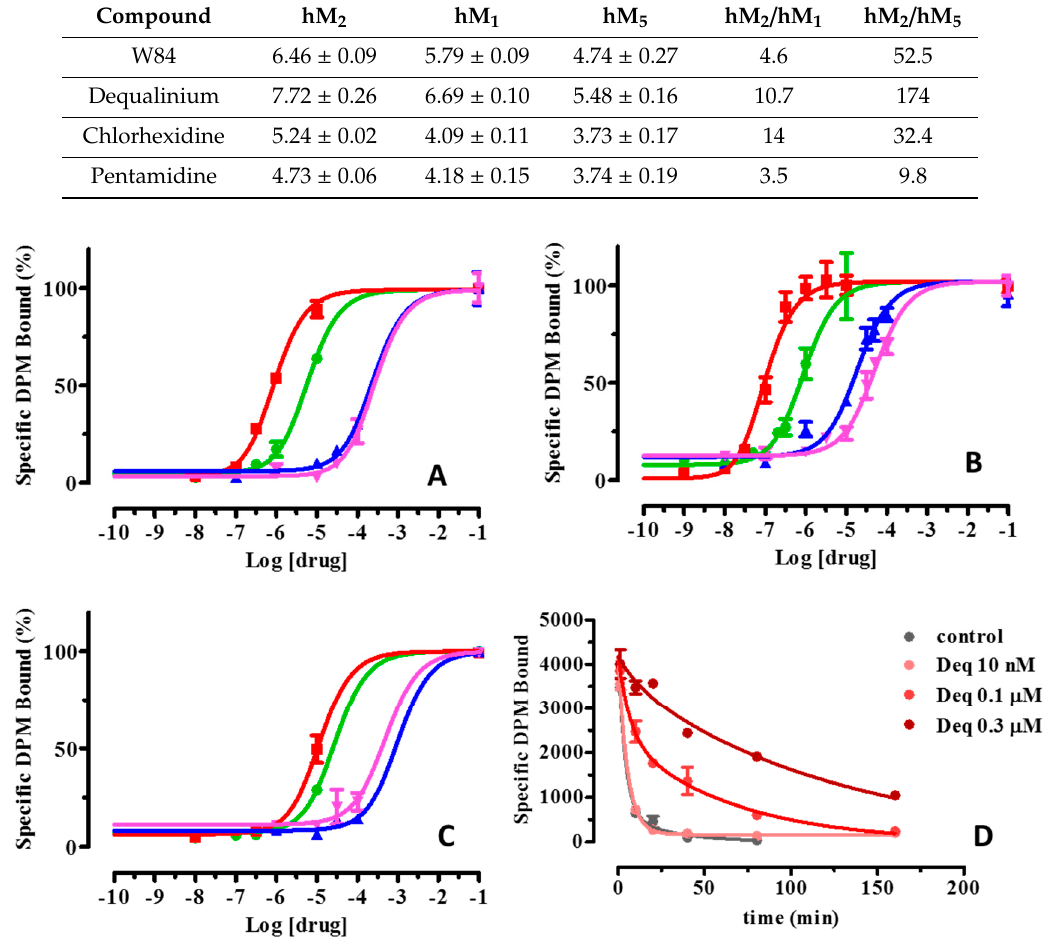
Figure 3. Effects on the [ 3 H]-NMS dissociation rate of three most interesting retrieved compounds (dequalinium: red squares, chlorhexidine: blue tringles and pentamidine: pink tringles) plus the reference W84 compound (green circles) as derived by single time-off rate experiments on ( A ) hM 1 , ( B ) hM 2 and ( C ) hM 5 . The data point at log [drug] = − 1 represents the [ 3 H]-NMS bound in the absence of added atropine and allosteric ligand; ( D ) shows a representative graph of the reduction of the dissociation rate (K off ) and the corresponding t 1/2 values of dissociation as obtained from full time course experiments for dequalinium on the hM 2 subtype.